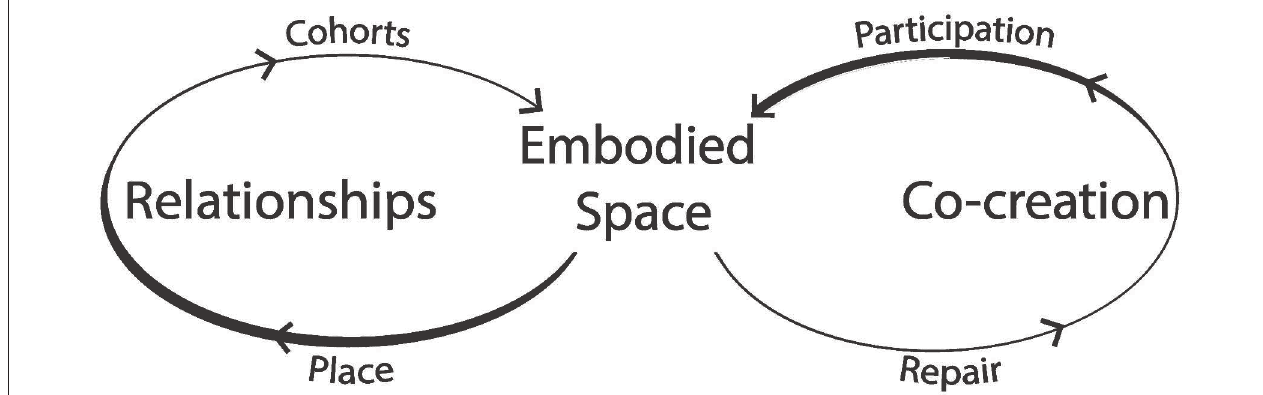
FIGURE 9 | Key Impacts of Embodied Space. Embodied space facilitates the development of cohort relationships, which creates the foundation for diverse participation structures for co-creation. In order to welcome people into these co-creation processes, ceremonies/rituals in embodied space heighten attention to role and responsibility transitions. The development of community-driven co-creative structures continues the process of repairing white supremacy and colonialism in research structures and relationships with socio-ecological systems. Repairing relationships and structures allows partnership members to contribute to generative, co-created embodied spaces (avoiding re-traumatization). Finally, the development of cohorts, co-creation structures, and reparative ecologies within the partnership comes back to relationships to place through collective work in “embodied spaces;” however, because of the work done in the rest of the cycle, our relationships to place have now changed and the cycle begins